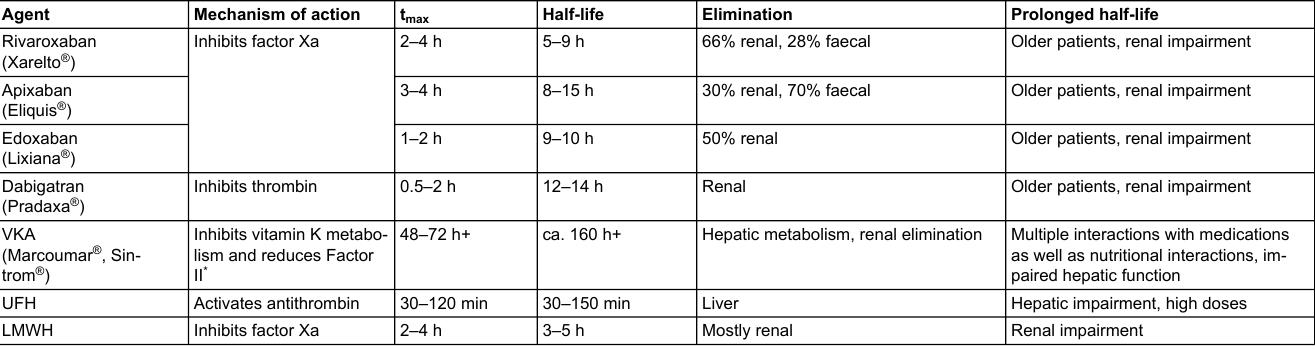
Table 2: Characteristics of commonly used anticoagulants: mechanism of action, pharmacokinetics and elimination.